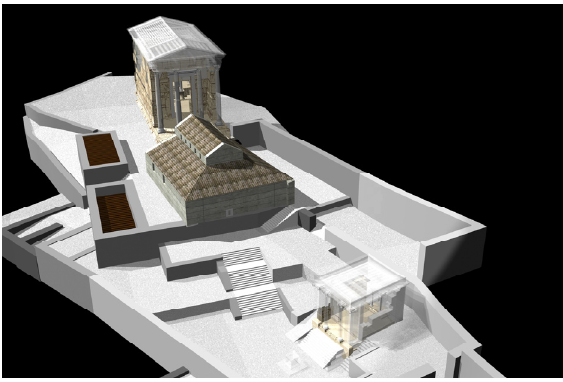
Figure 16. The architectural 3D model of the Byzantine church surrounded by the two destroyed temples of Hosn-Niha . © J. Yasmine; 2005. The 3D architectural model of the last state of the sanctuary (Fig. 16) as rendered by 3DS Max uses transparent walls / ceilings indicating the shape of the destroyed